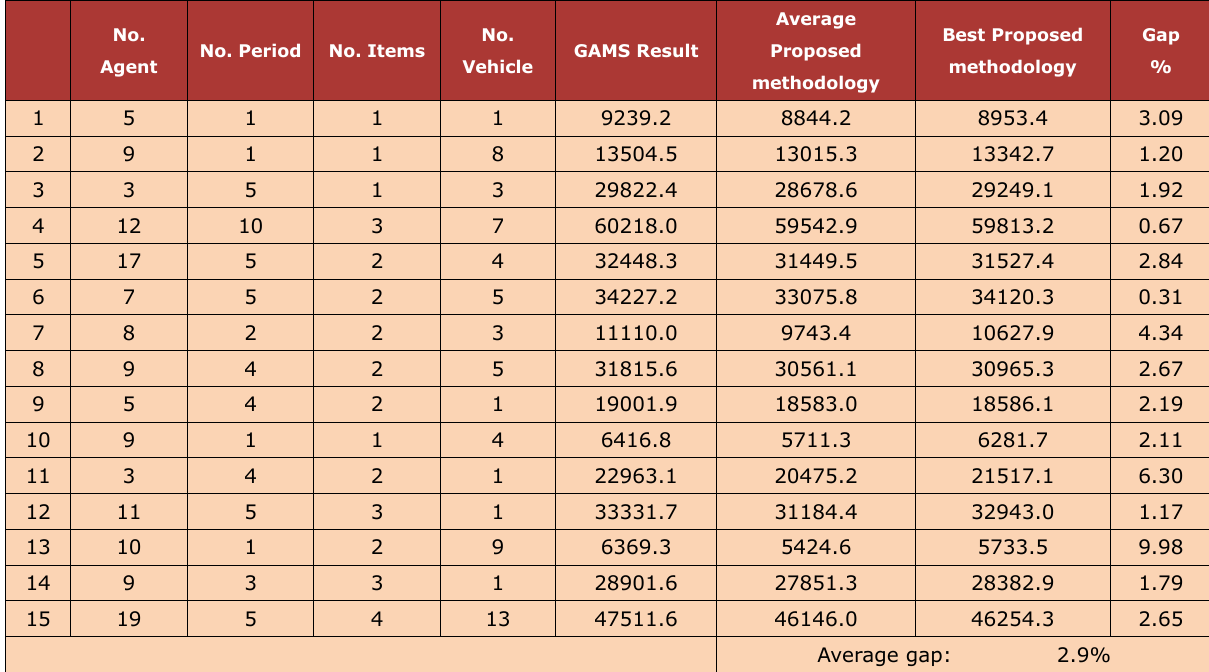
Table 4. Comparison between GAMS and Proposed